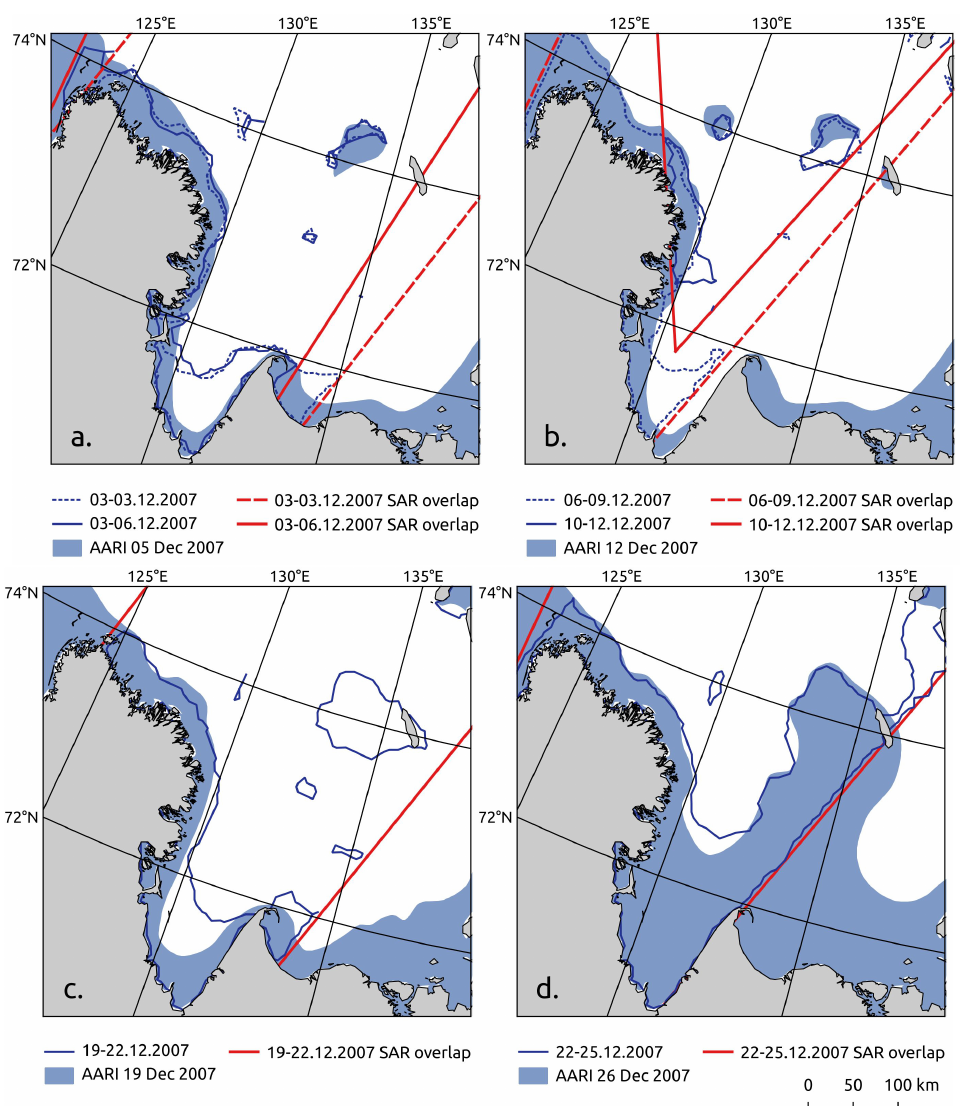
Figure 5. The retrieved ENVISAT-based fast ice polygons and the corresponding AARI fast ice data for the Laptev Sea region for 3–6 Demember 2007 ( a ), 6–12 December 2007 ( b ), 19–22 December 2007 ( c ), 22–26 December 2007 ( d ). The dates in the legend correspond to the timing of the first and the second SAR images and the issue date of the AARI ice